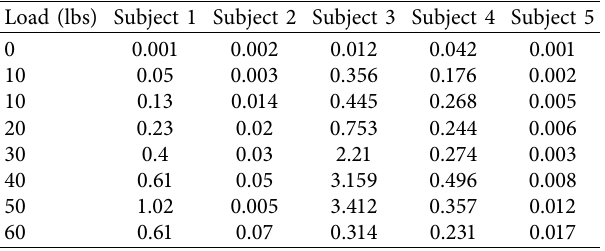
Table 2: Relative muscle strength of different subjects under different loads.